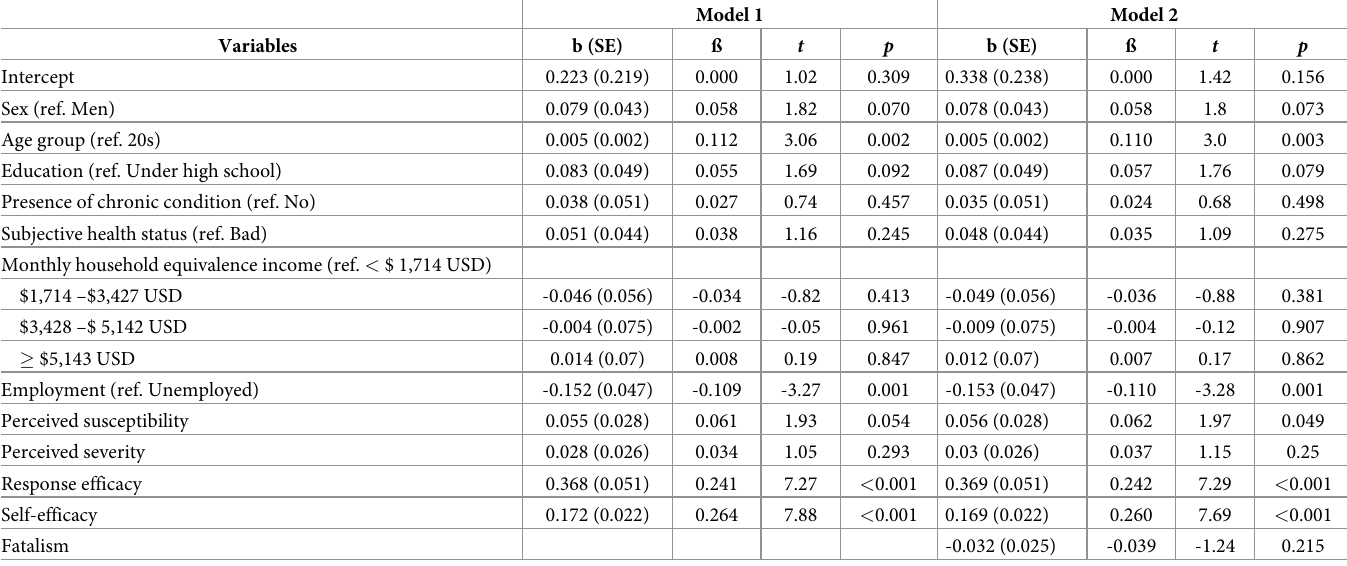
Table 5. Multiple regression analysis predicting the danger control responses- social